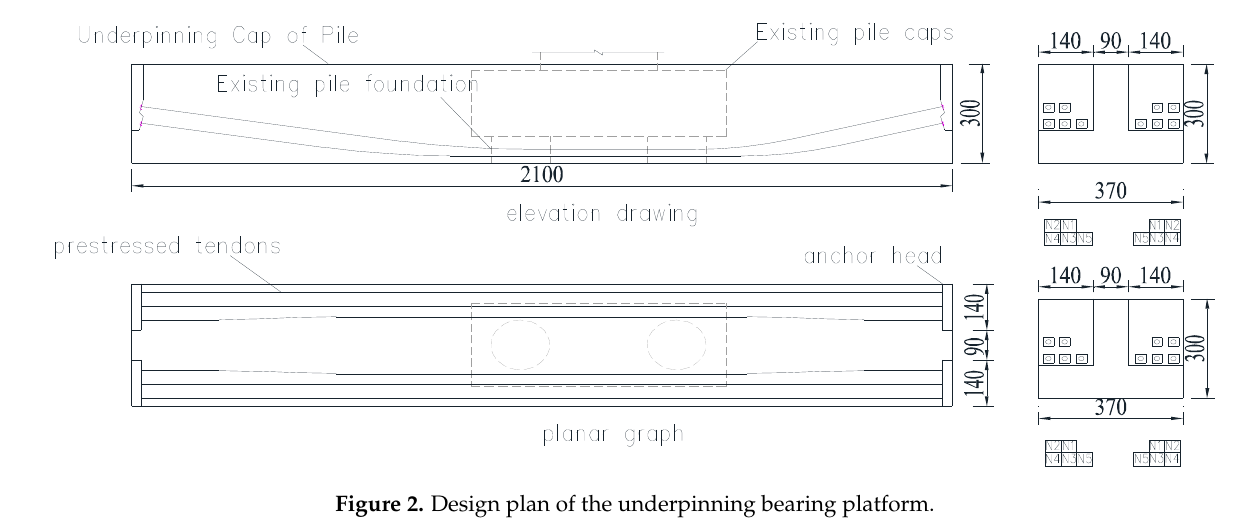
Figure 2. Design plan of the underpinning bearing platform.